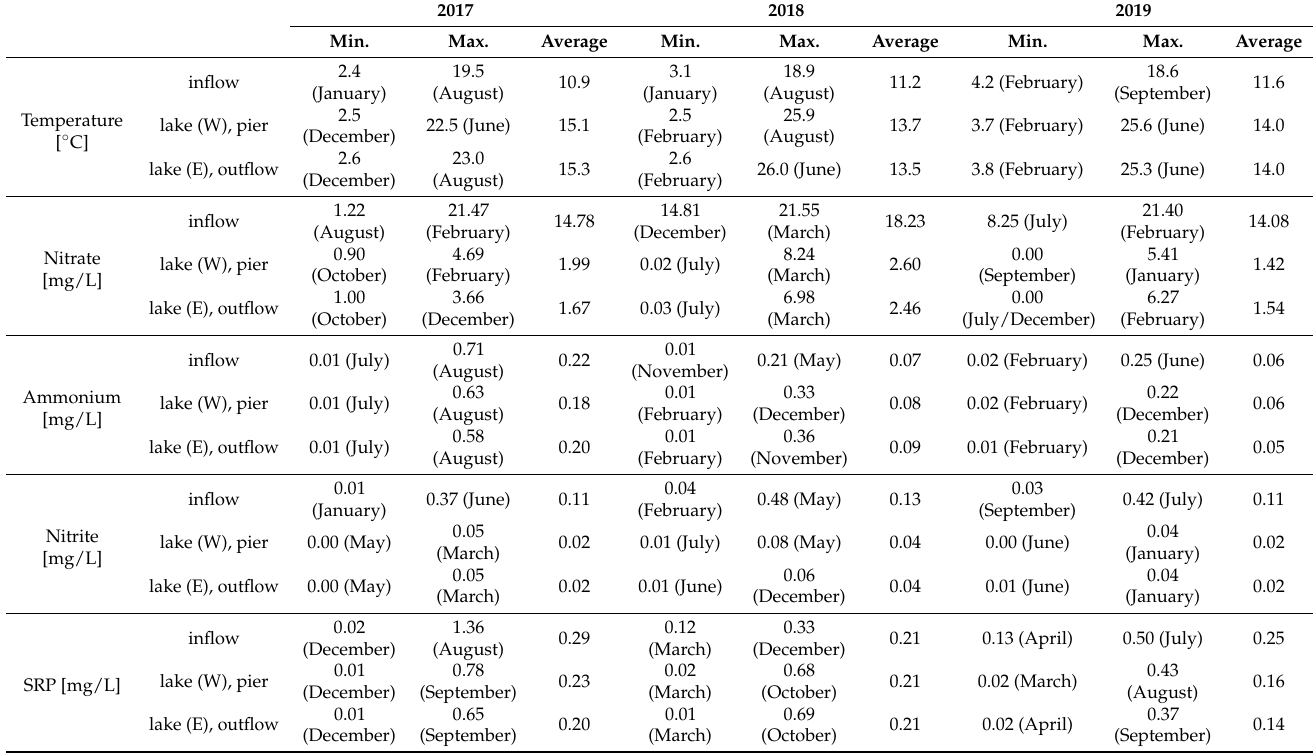
Table 1. Minimum, maximum, and average temperatures and nutrient concentrations for the inflow (Aue creek), western (pier), and eastern (near the outflow) parts of Lake Seeburg. 2017 2018 2019 Min. Max. Average Min. Max. Average Min. Max.